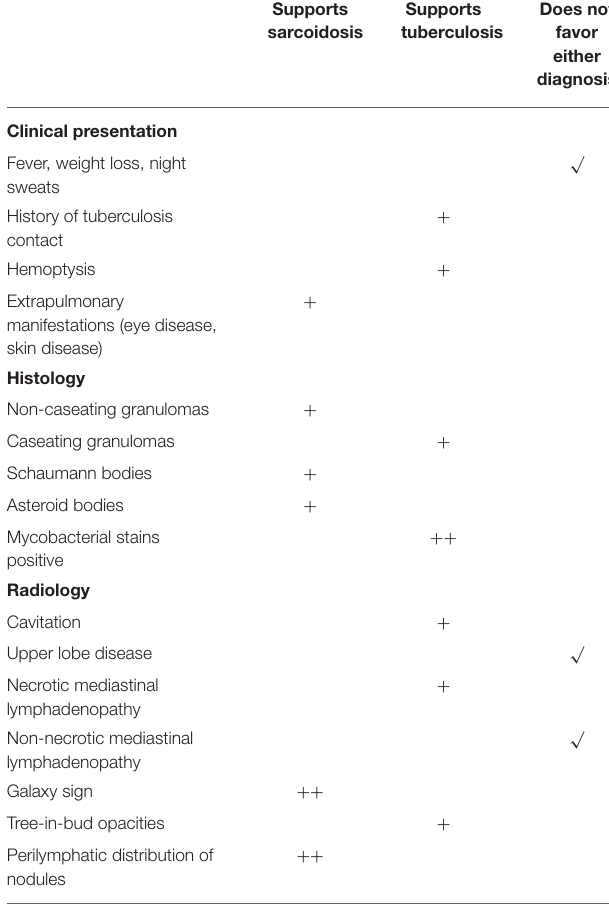
TABLE 2 | Clinical data supporting the possibility of sarcoidosis vs. tuberculosis. Supports